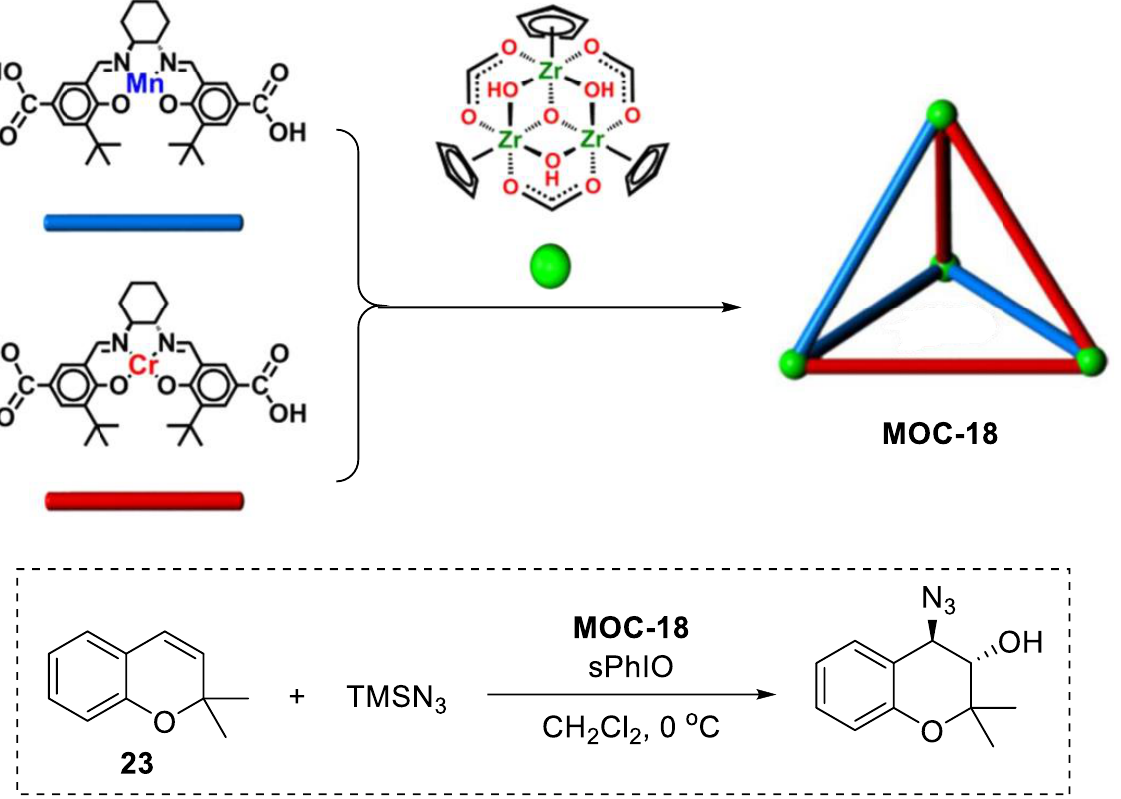
Figure 18. Asymmetric epoxidation/epoxide ring-opening reactions of 2,2-dimethyl-2H-chromene (DMCH) with TMSN 3 catalyzed by MOC -18 [89]. Reaction conditions: 23 (0.1 mmol), MOC-18 (0.1 mol%), sPhIO (100 mol%), CH 2 Cl 2 , 0 °C. Reprinted/adapted with permission from Ref. [89]. Copyright 2018 American Chemical Society.